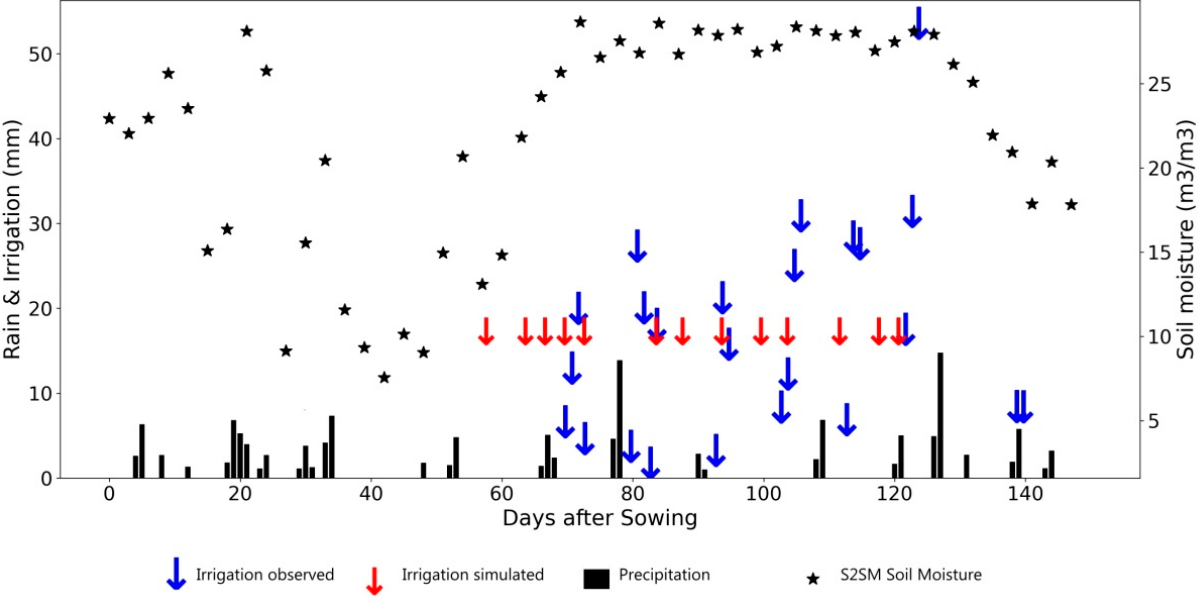
Figure 13. Same as Figure 12 for a potato field in Niedersachsen in 2018 (high irrigation frequency and low amounts of irrigation).